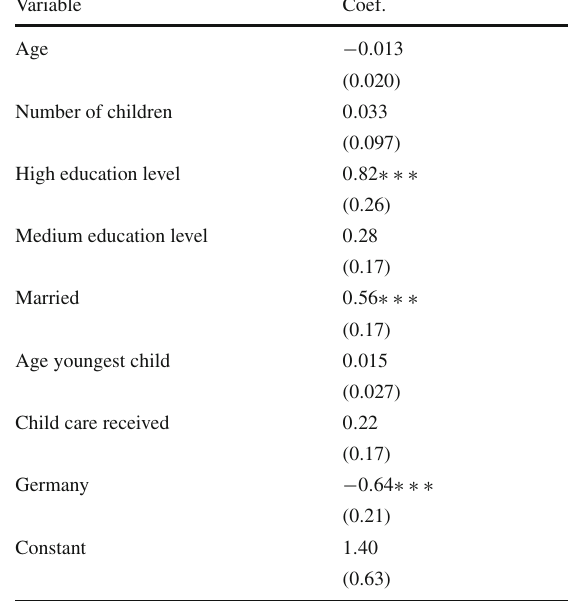
Table 8 Probit estimates of the labor participation decision of the